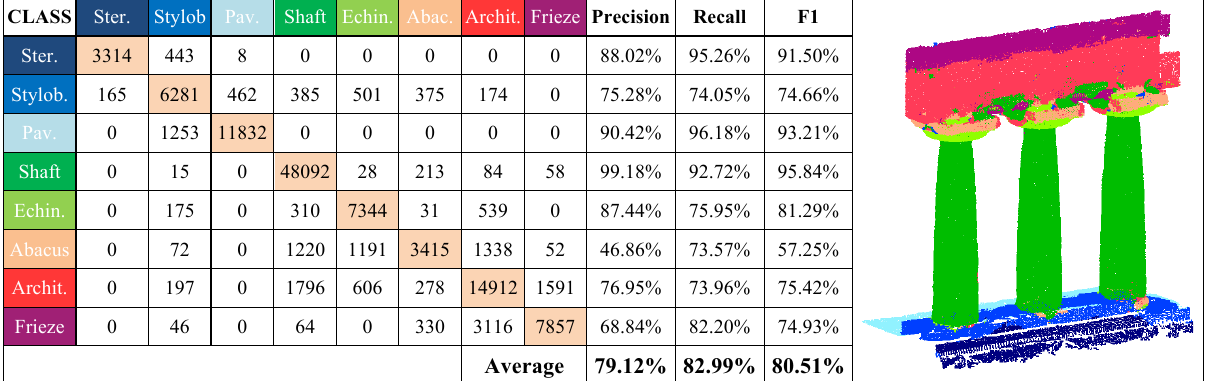
Table 4. Confusion matrix and results for the Basilica dataset, using 8 geometric features ad hoc. CLASS Ster. Stylob Pav.